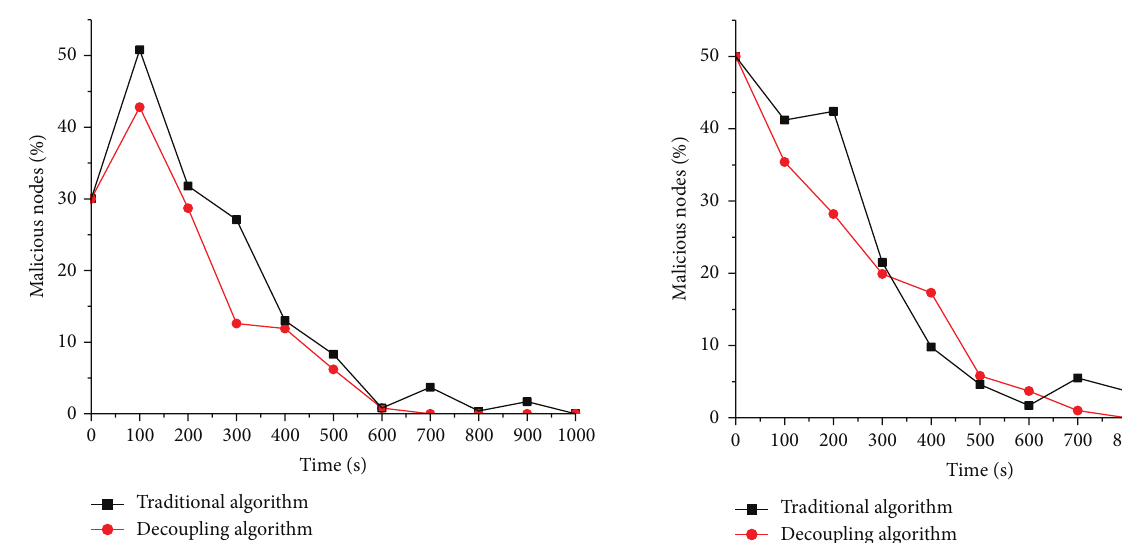
Figure 4: Percentage of the malicious suspicious virtual machine node is 50%.